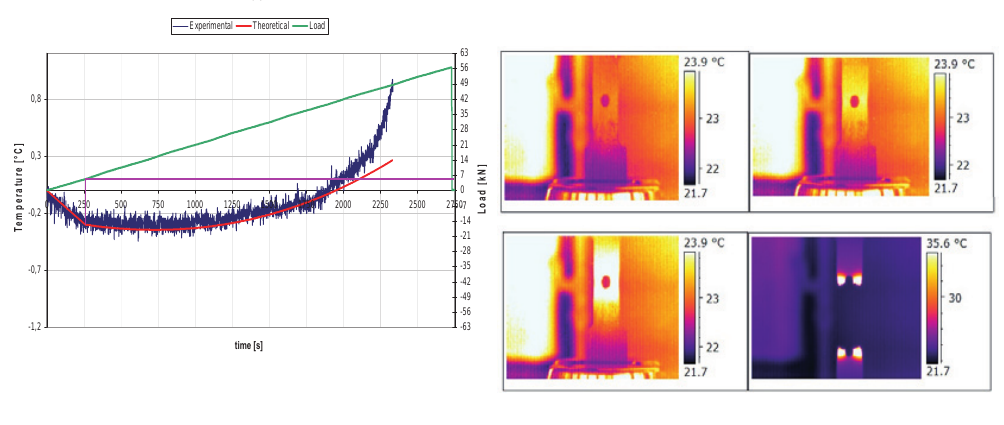
Fig. 5. Temperature evolution curves . Fig. 6. Thermographic images of the specimen